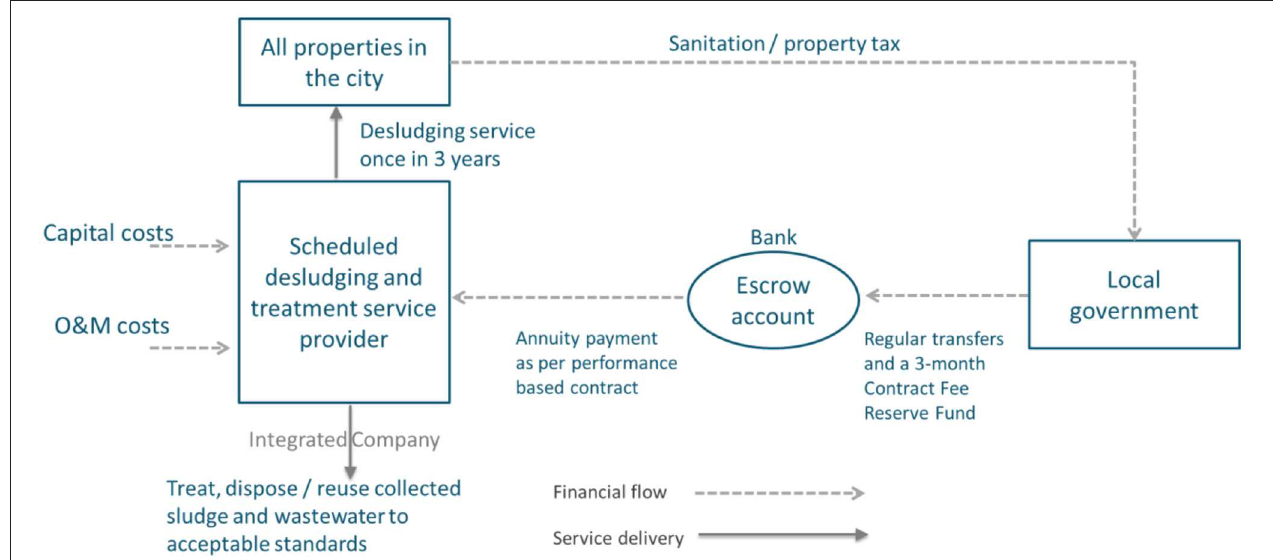
FIGURE 1 | Performance-based Annuity Model for Scheduled Emptying. Source: CWAS, CEPT